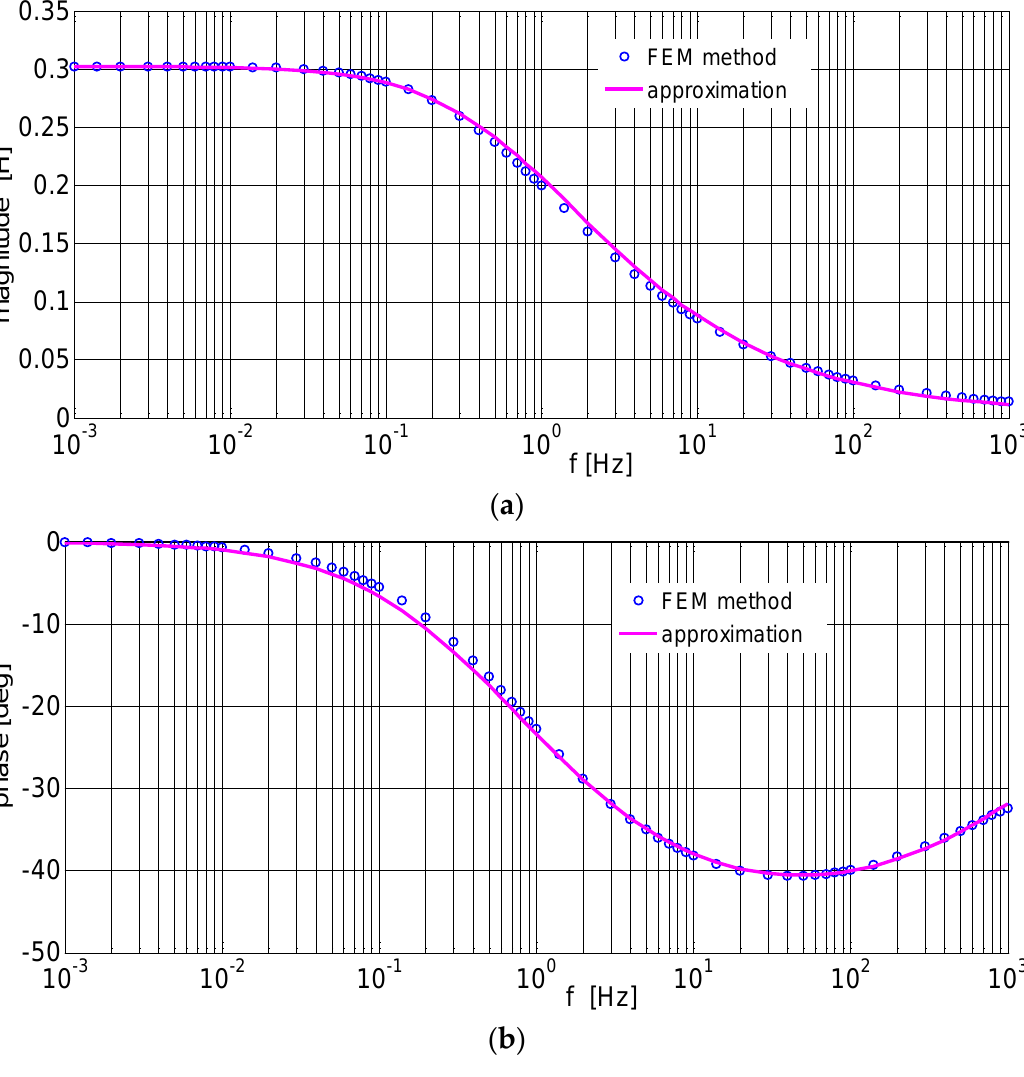
Figure 6. Frequency characteristics of the spectral inductance L s (jf): ( a ) magnitude, ( b ) phase. To compare the magnitude and phase characteristics of the spectral inductances calculated by the finite element method and obtained as a result of the approximation by means of the fractional-order transform functions (15), the relative error defined as [28] was